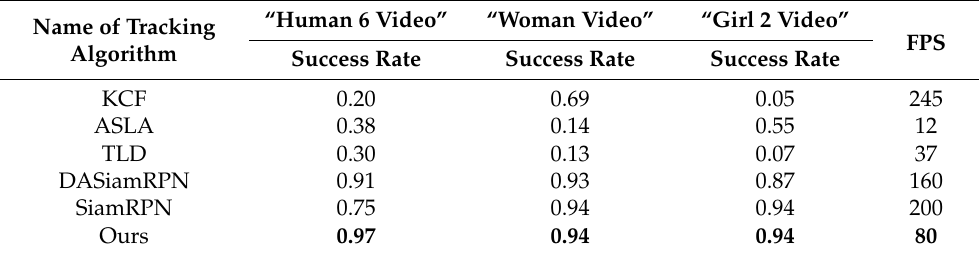
Table 3. Tracking success rate list of each tracking algorithm in several pedestrian videos of OTB-100. ASLA: adaptive structural local sparse appearance; TLD: tracking learning detection; FPS: frames per second. SiamRPN: Siamese region proposal network; DASiamRPN: distractor-aware